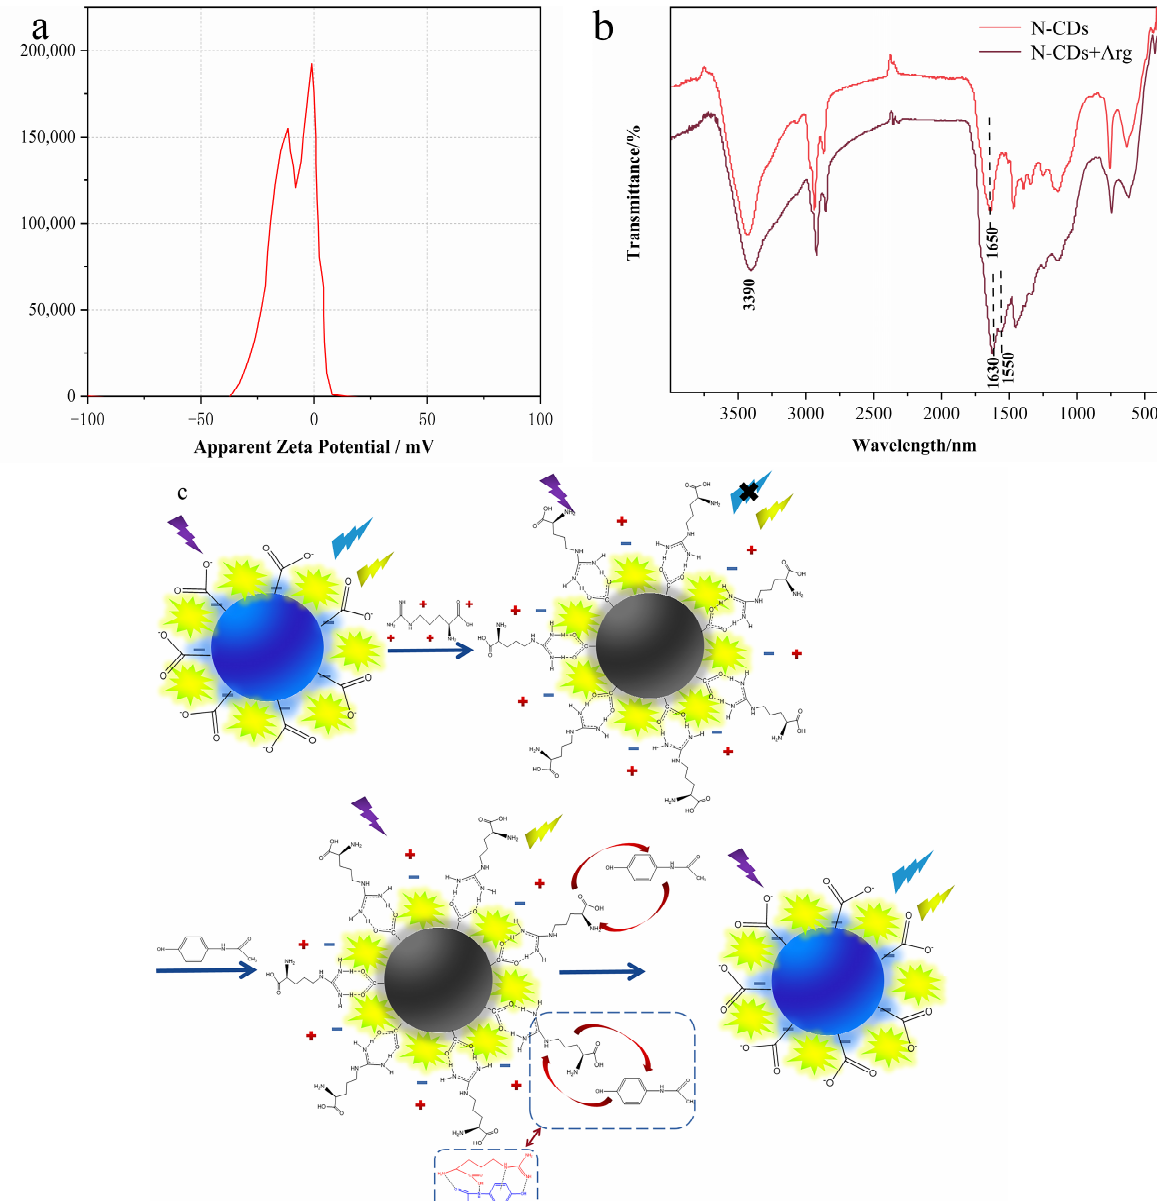
Figure 15. ( a ) Zeta potential of N-CDs; ( b ) FTIR spectra of N-CDs, N-CDs and Arg; ( c ) possible reaction mechanism of our N-CD/calcein sensor when detecting Arg and